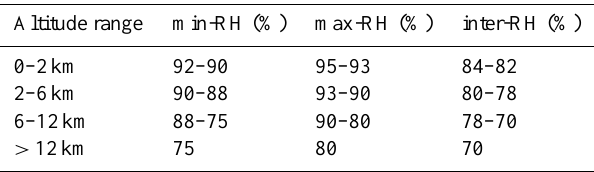
Table 1. Summary of height-resolving RH thresholds for cloud de- tection.